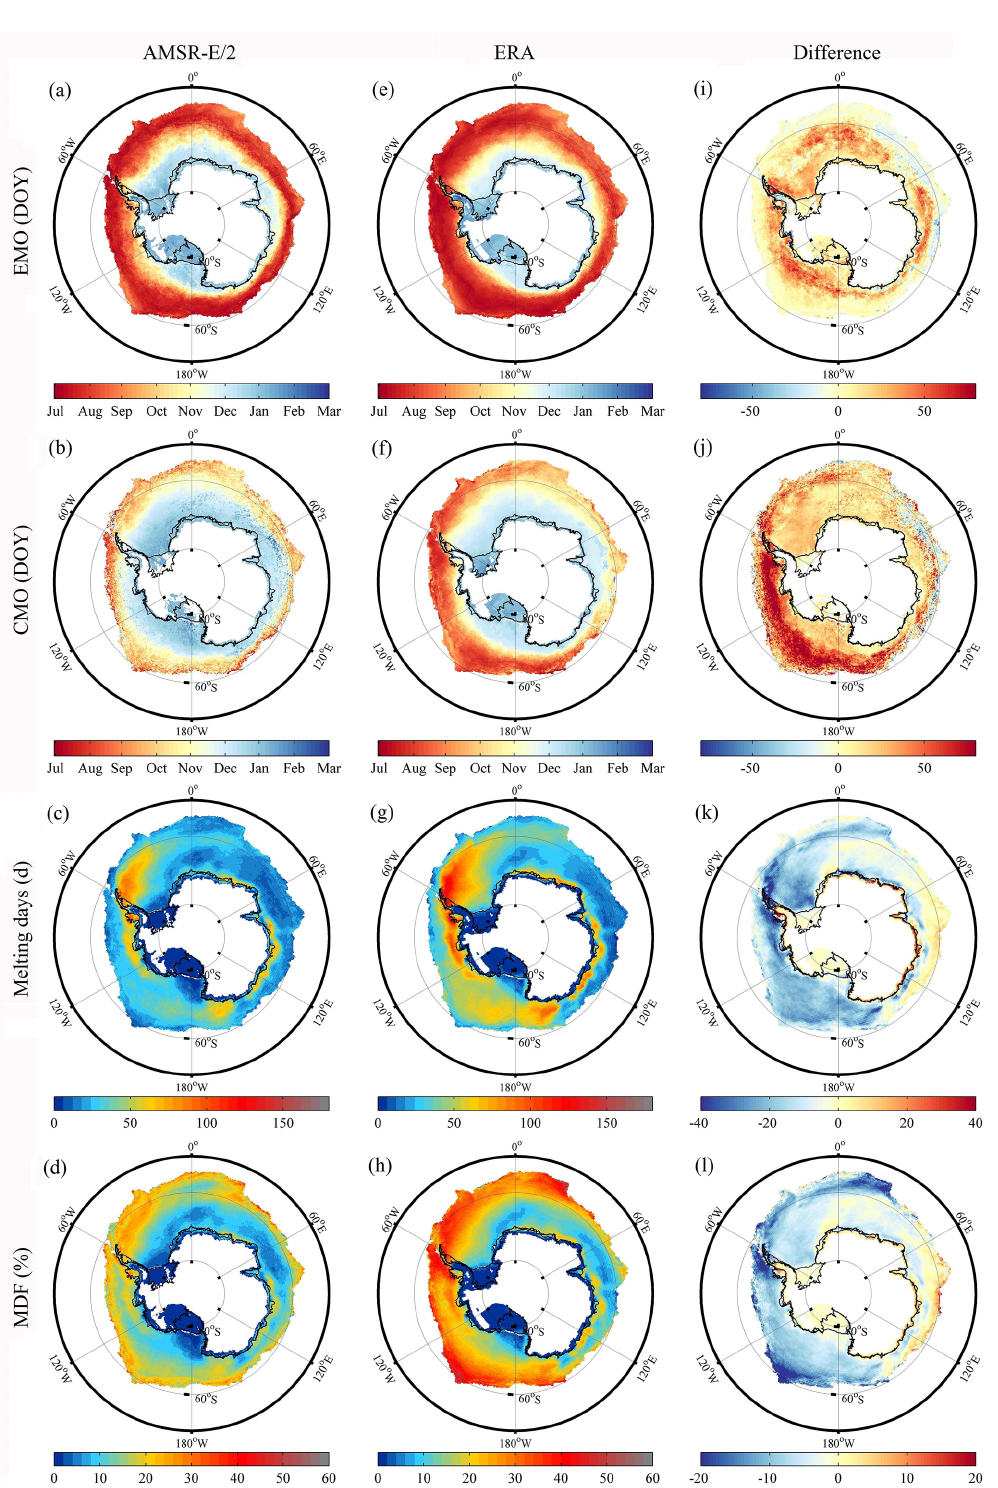
Figure 4. Annual mean EMO, CMO, melting days and MDF derived by AMSR-E/2 (a–d) and ERA-Interim (e–h) . Also shown are the differences (AMSR-E/2 minus ERA-Interim) between the two observations (i–l)